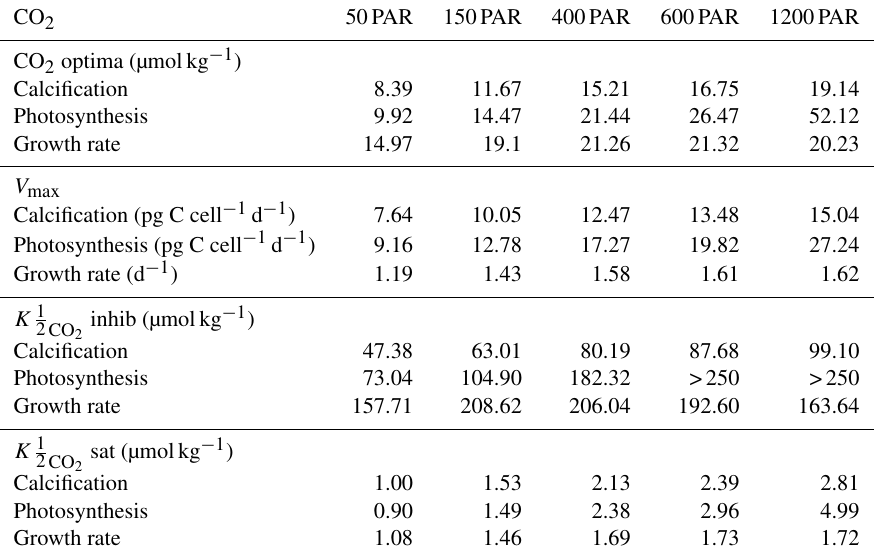
concentrations and maximum rates ( V max ) at 50–1200µmolphotonsm − 2 s − 1 from Eq. 2